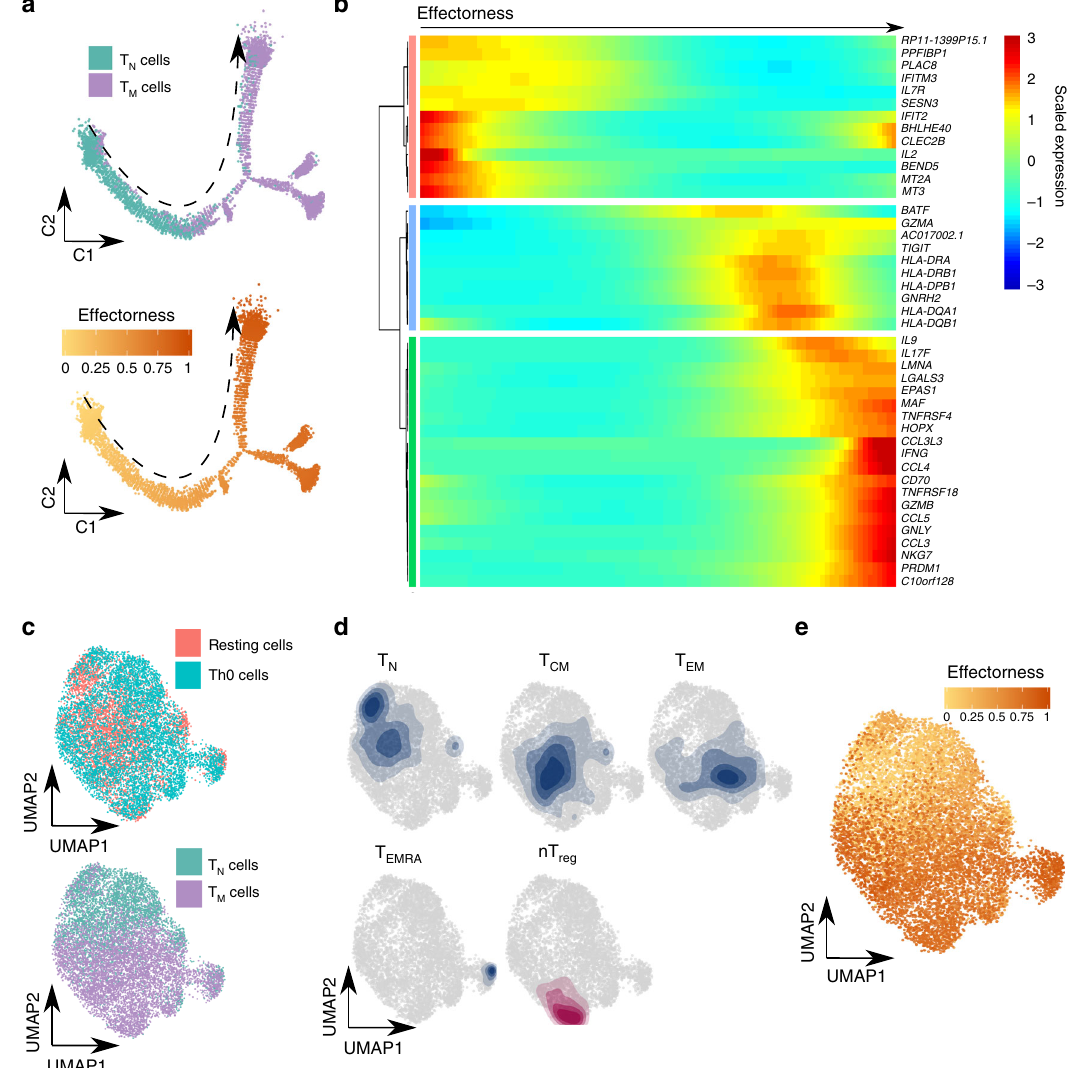
Fig. 4 The effectorness gradient is preserved after T cell activation. a Th0-stimulated T N and T M cells ordered in a branched pseudotime trajectory. Cells are colored by cell type (top panel) or effectorness (bottom panel). b Heatmap of the most variable genes along the Th0 pseudotime trajectory (Methods). The x axis represents cells ordered by effectorness (from left to right) and colors correspond to the scaled (Z-scored) expression of each gene in each cell. c Mapping of Th0-stimulated cells to their corresponding resting T cell populations. Integration of resting and Th0-stimulated cells using canonical correlation analysis (Methods) followed by UMAP embedding. Cells are colored by activation status (resting vs Th0, top panel) or cell type (bottom panel). d Density plots highlighting the location of cell clusters as de fi ned in resting state. e UMAP embedding color-coded by the effectorness values of resting and stimulated cells. Source data are provided as a Source Data fi